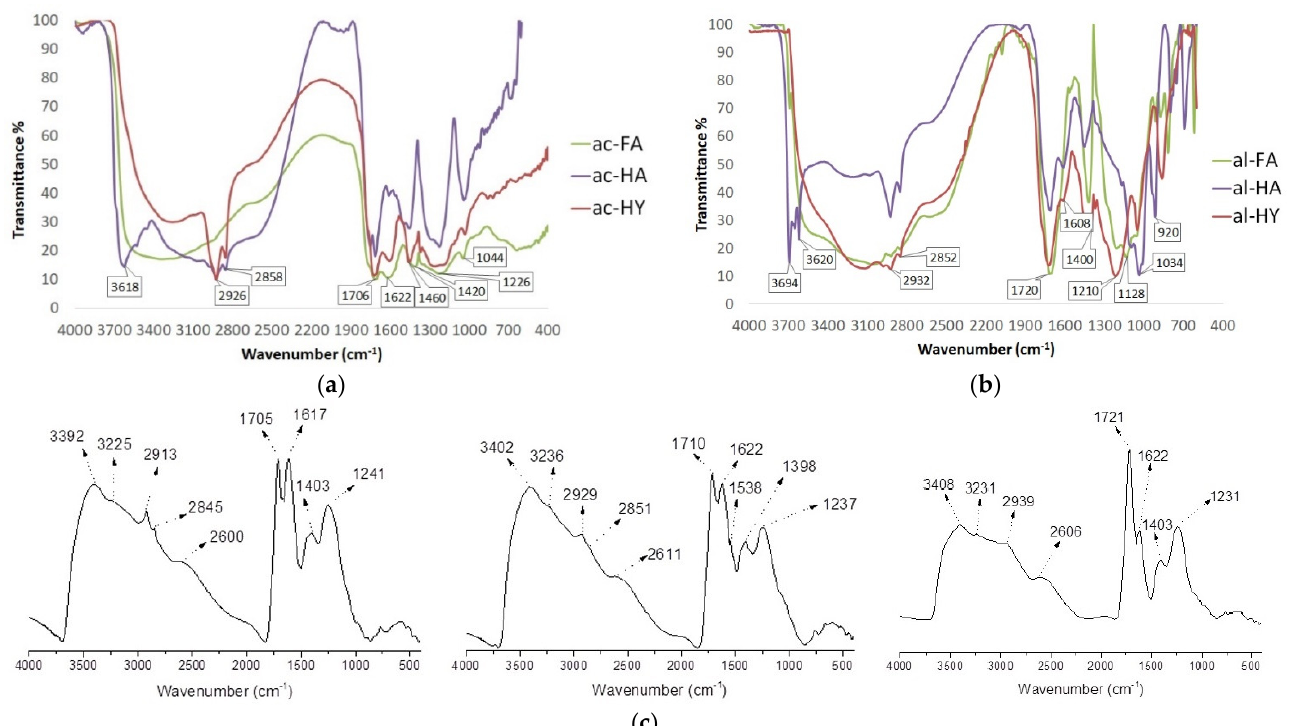
Figure 1. The different FT-IR spectra of the fractions are shown to compare the self-extracted samples with the IHSS samples: ( a ) acid-extracted fractions. ( b ) alkaline-extracted fractions. ( c ) IHSS standard samples from the official IHSS website: IHSS HAL (1S104H—on the left), IHSS HAP (1S103H—on the middle), and IHSS FAP (2S103F—on the right) [32].